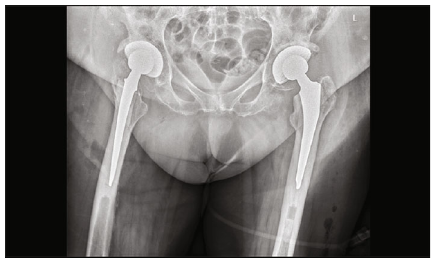
Figure 2: Postoperative anteroposterior X-ray of the pelvis.